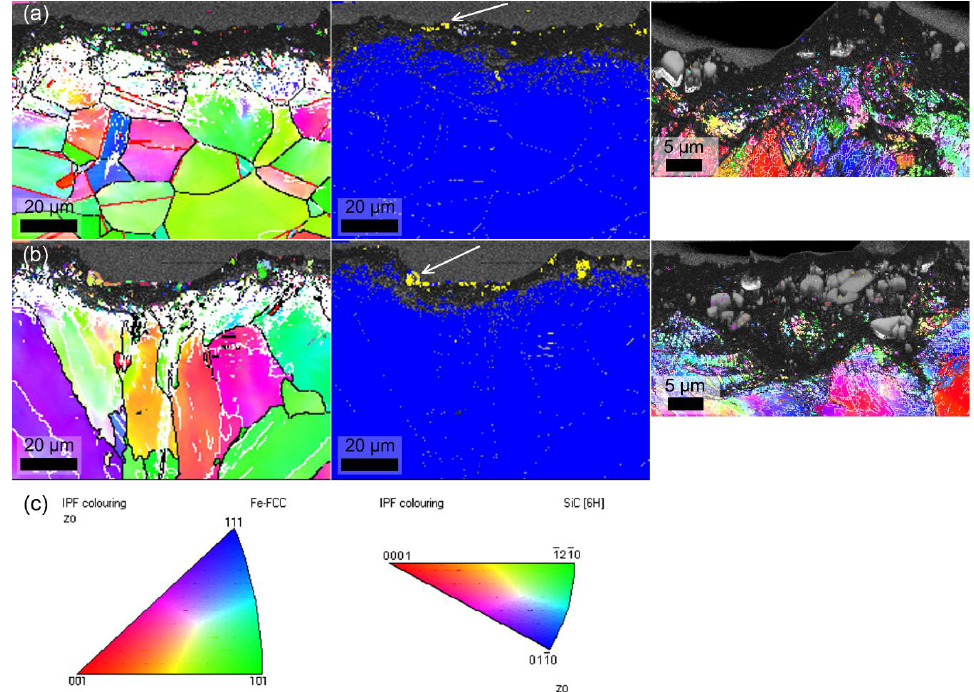
Figure 5. Inverse pole figure (IPF) map superimposed on band contrast (BC) map (with two magnifications, left side and right side) and phase map (middlemost) superimposed on BC map collected after shot peening from ( a ) reference sheet sample (SP, 3 s) and ( b ) AsB AM sample (SP, 2 s). Colors in IPF maps correspond to orientations (z direction), as indicated by ( c ) IPF coloring key for austenite (Fe-FCC) and silicon carbide (SiC). On BC + IPF maps, low-angle boundaries (2–10°) are marked by white lines, high-angle boundaries (>10°) by black lines and twin boundaries (60° <111>) by red lines. In phase maps, iron (austenite) is blue and silicon carbide is yellow, and some of the residual silicon carbides are marked by arrows.